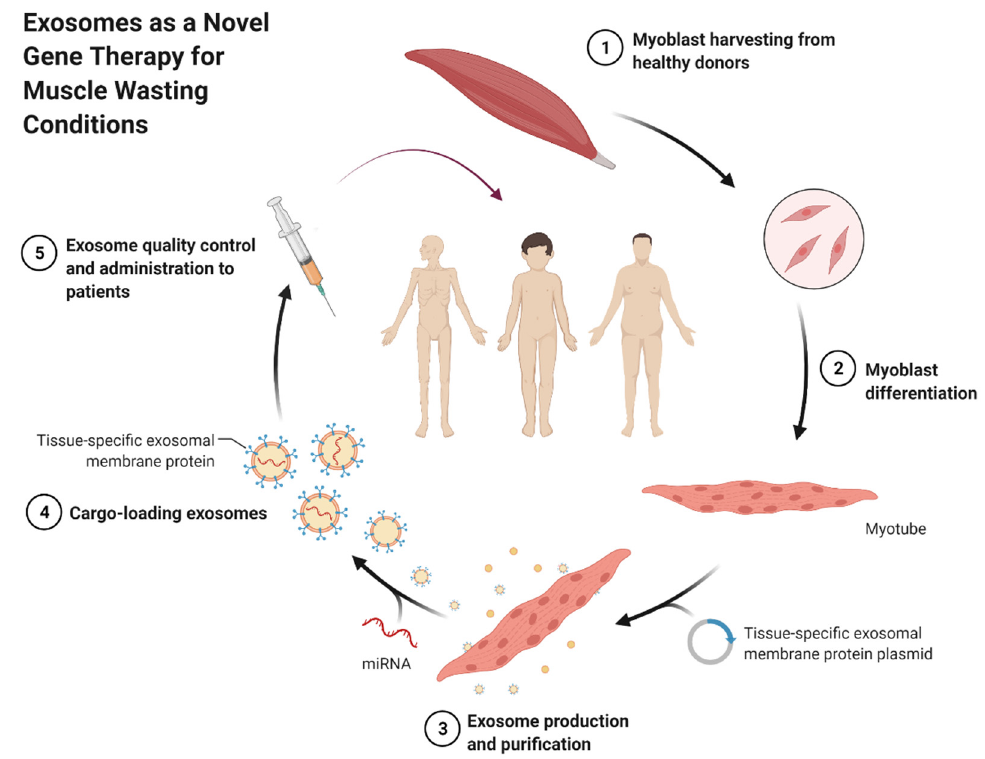
Figure 4. Exosomal gene therapy for muscle-wasting conditions [158] (adapted from BioRender.com (accessed on 28 October 2021)). 2021 Copyright